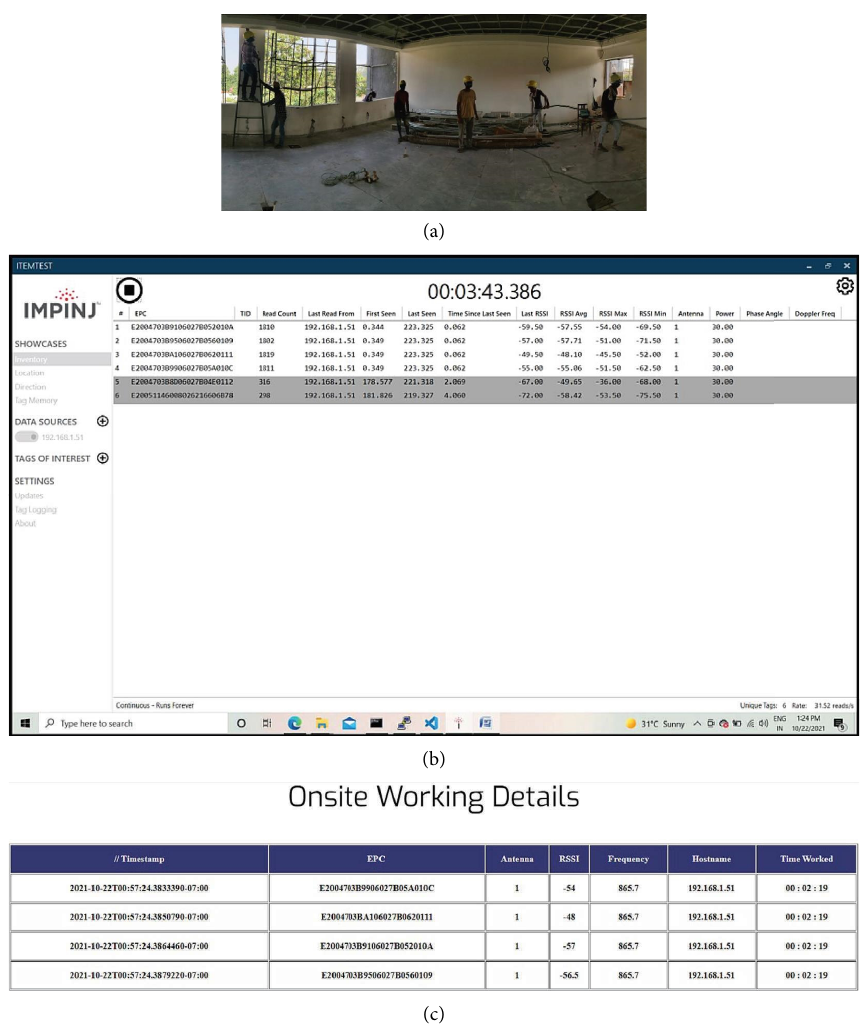
Figure 26: (a) Construction site with remaining workers (wearing tagged helmets) after few workers left the site. (b) Remaining tagged workers being recognized by item test software from Impinj. (c) Details of on-site workers being displayed on developed web-based